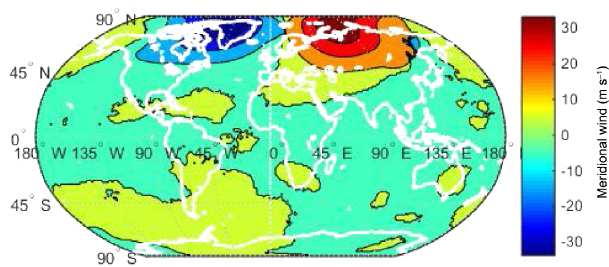
Figure 5. Meridional wind (ms − 1 ) climatology for January from 1998 to 2015 in the MERRA